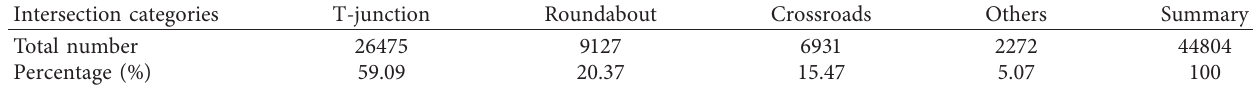
Table 1: The statistics of total bicycle crashes at various intersections (2009–2018).